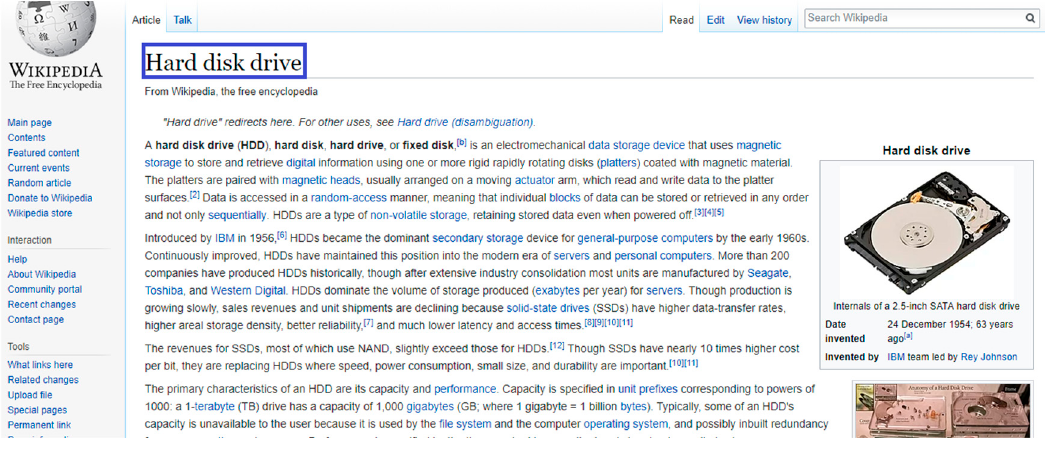
Figure 2. Verification of compound nouns.